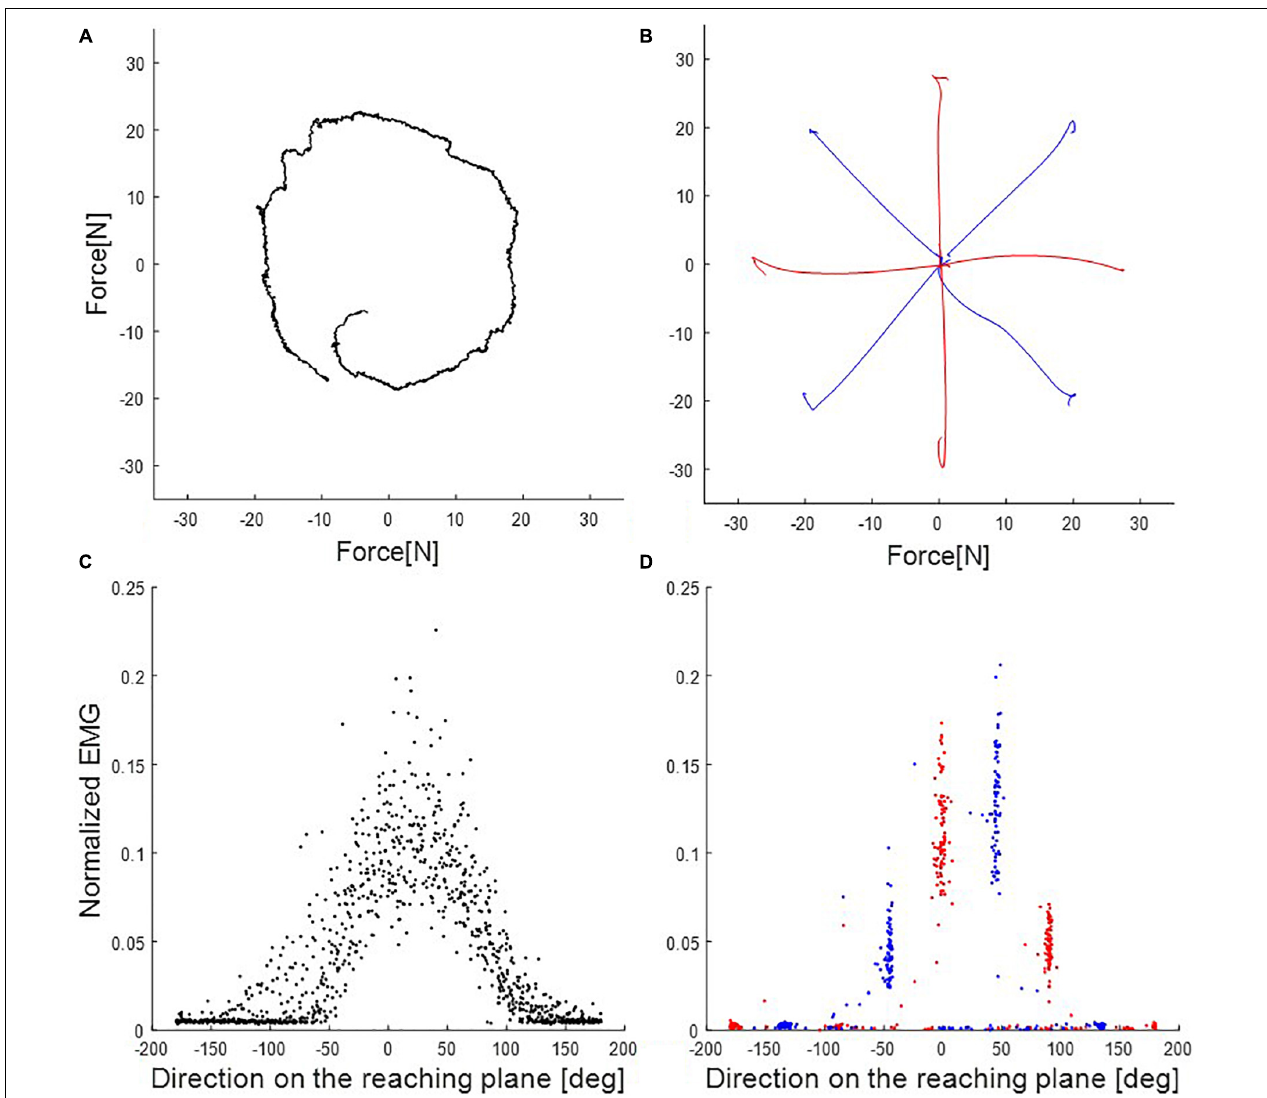
FIGURE 2 | End-point force trajectory and electromyography (EMG) activations in rotating and multidirection reaching tasks of the representative subject (subject 8). (A) Rotating task (condition 1) in one trial of 20N trials. (B) Multidirection reaching task in trials of 20% of Maximum voluntary contraction’s (MVC’s) maximum magnitude. Condition 2 used all eight targets. Conditions 3 and 4 (red and blue traces, respectively) used subsets of four targets each in different direction. (C) EMG activations of the posterior deltoid according to direction on the reaching plane (trials of 20N in the rotating task). Black dots are EMG activation in the rotating task (condition 1). (D) EMG activations of the posterior deltoid according to direction on the reaching plane (trials of 20% of the maximum value of MVC in the multidirection reaching task). Red and blue dots are EMG activation in the multidirection reaching task (condition 2). Red and blue dots are subsets, respectively, for conditions 3 and